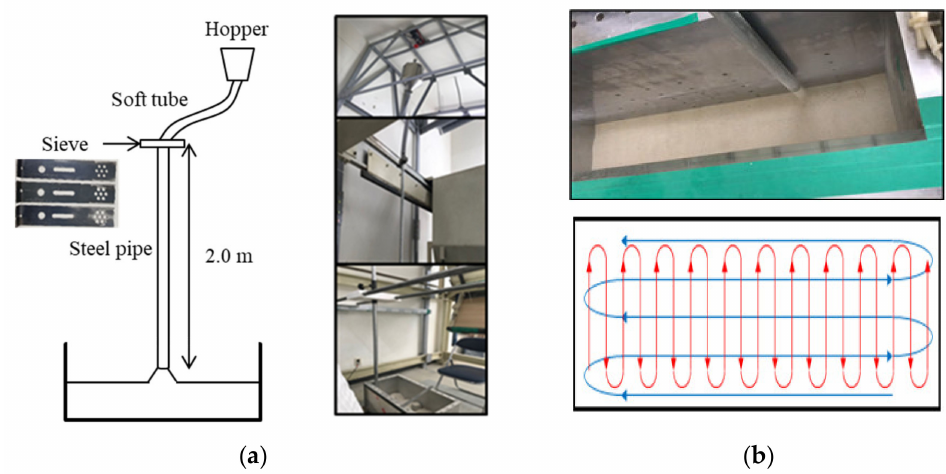
Figure 5. Sand pluviation using funnel: ( a ) equipment diagram and ( b ) composition method. The model ground is created from left to right (blue solid line) and then vertically